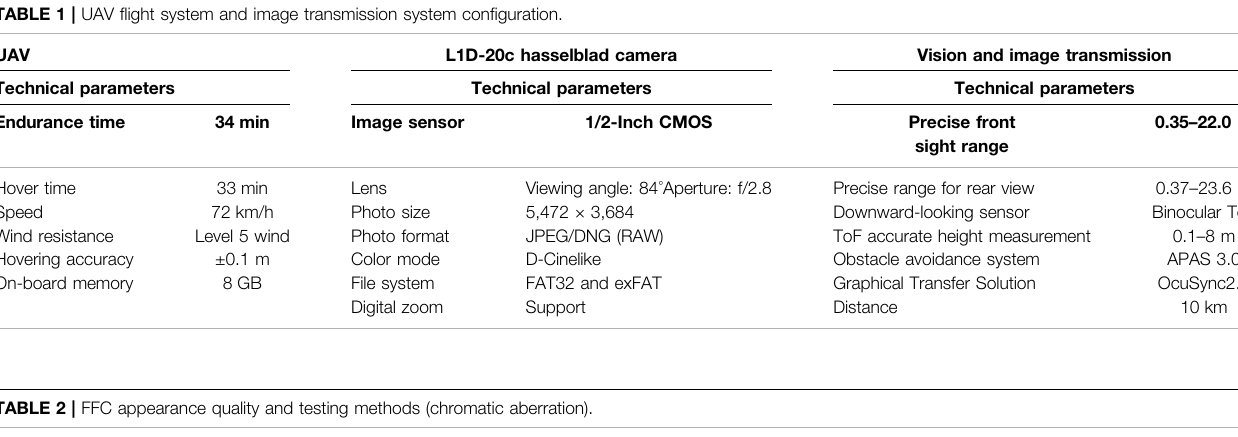
TABLE 1 | UAV fl ight system and image transmission system con fi guration.